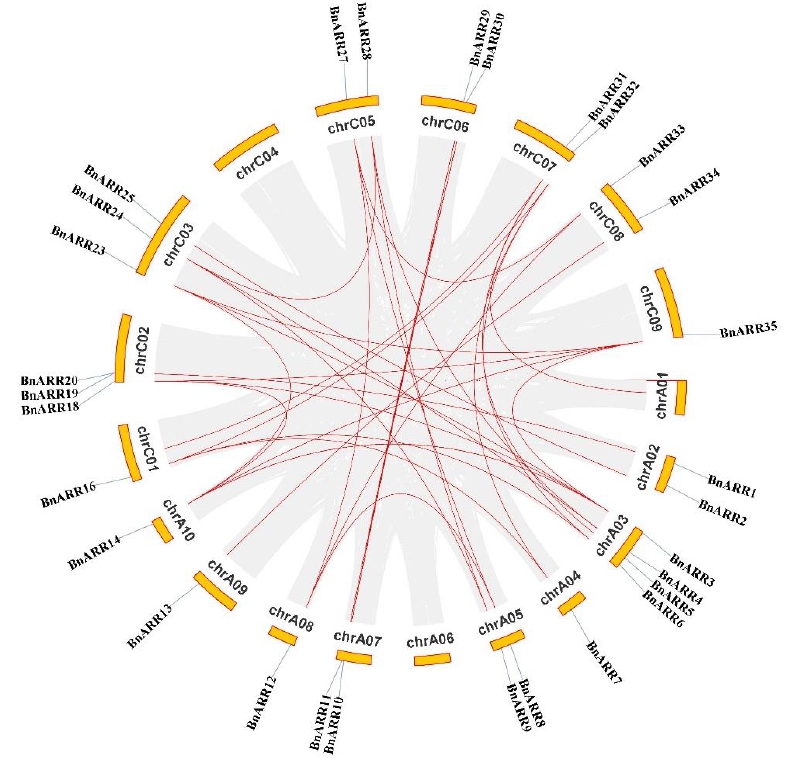
Figure 5. Synteny of type-B ARRs in B. napus . The gray lines represent synteny blocks in rapeseed genome, and red lines represent BnARR gene pairs.